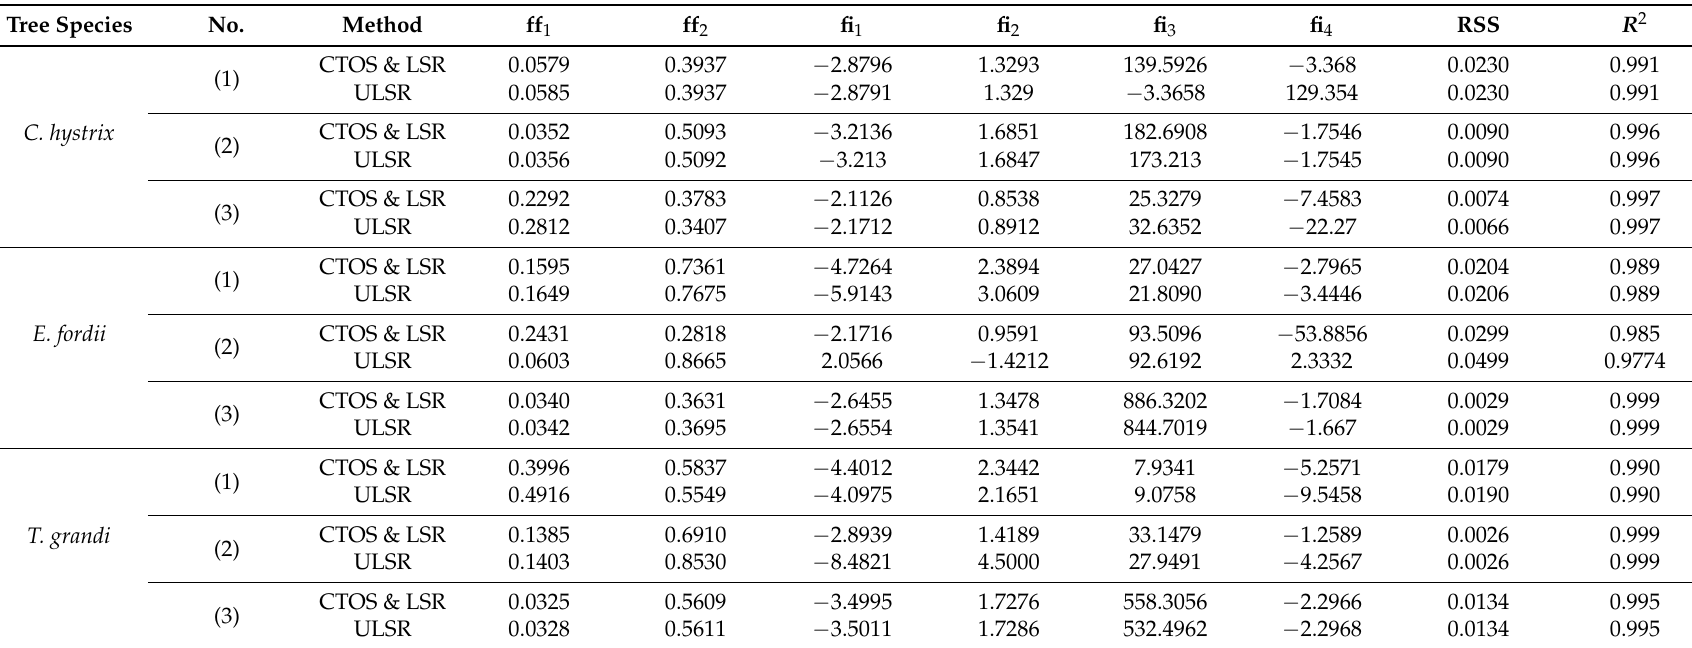
Table 2. Parameter estimates and statistics of Equation (1) fitted by a combined method of constrained two-dimensional optimum seeking and least square regression (CTOS & LSR) and the unconstrained least square regression (ULSR) for nine individual trees (three trees from each species of C. hystrix , E. fordii, and T. grandis